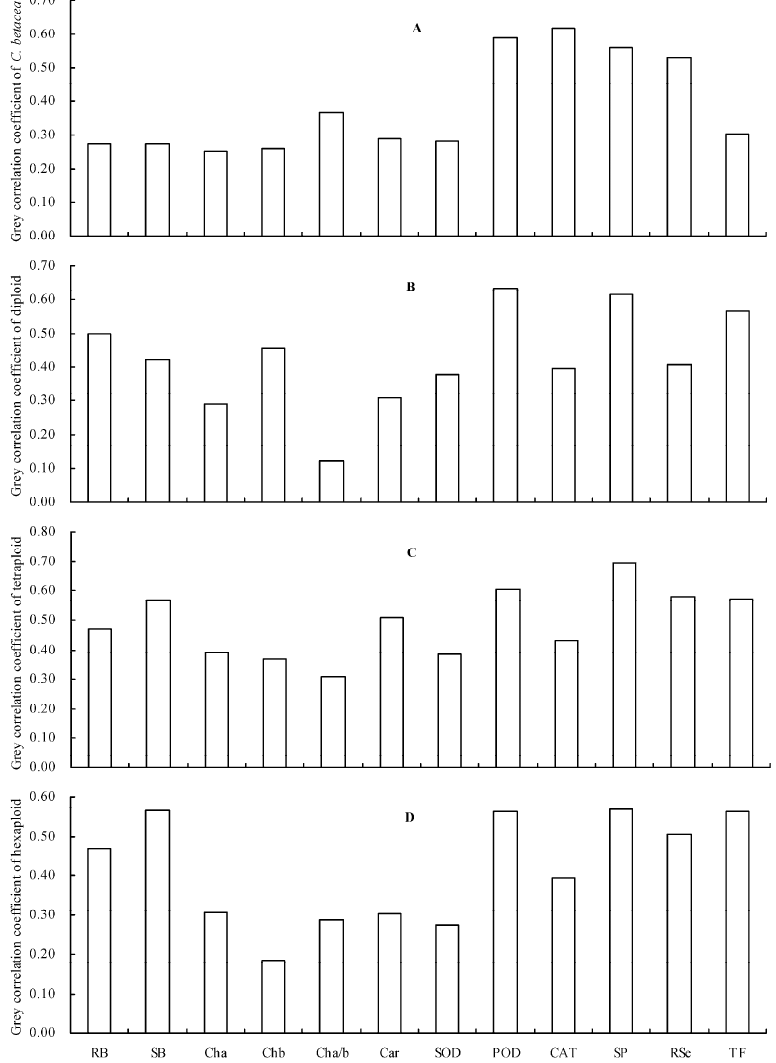
Figure 5. Grey correlation coefficients of the different indicators with the shoot Se content. ( A ) C. betacea ; ( B ) diploid; ( C ) tetraploid; ( D ) hexaploid. RB = root biomass; SB = shoot biomass; Cha = chlorophyll a content; Chb = chlorophyll b content; Cha/b = chlorophyll a / b ; Car = carotenoid content; SOD = SOD activity; POD = POD activity; CAT = CAT activity; SP = soluble protein content; RSe = root Se content; TF = translocation